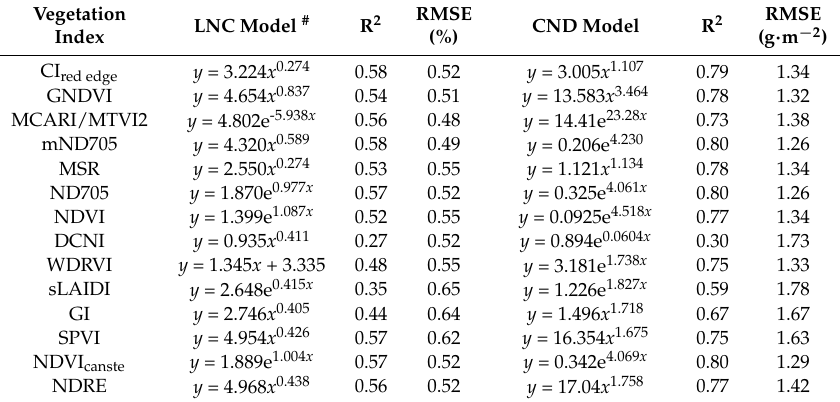
Table 8. Relationships between LNC and vegetation indices ( n = 384).